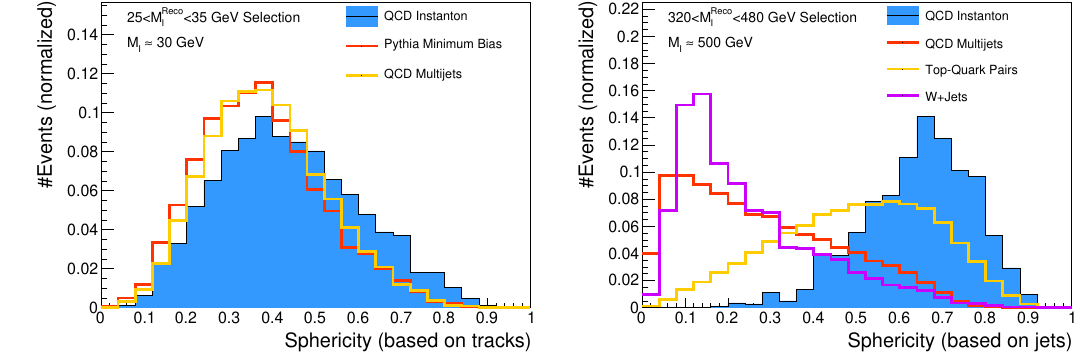
Figure 11 . Normalized spherity distributions of reconstructed tracks for events with 25 < M reco 35 GeV (left) and of reconstructed particle-jets for events with 320 < M reco Beside the signal processes, the expected distributions of the background processes are shown (see table